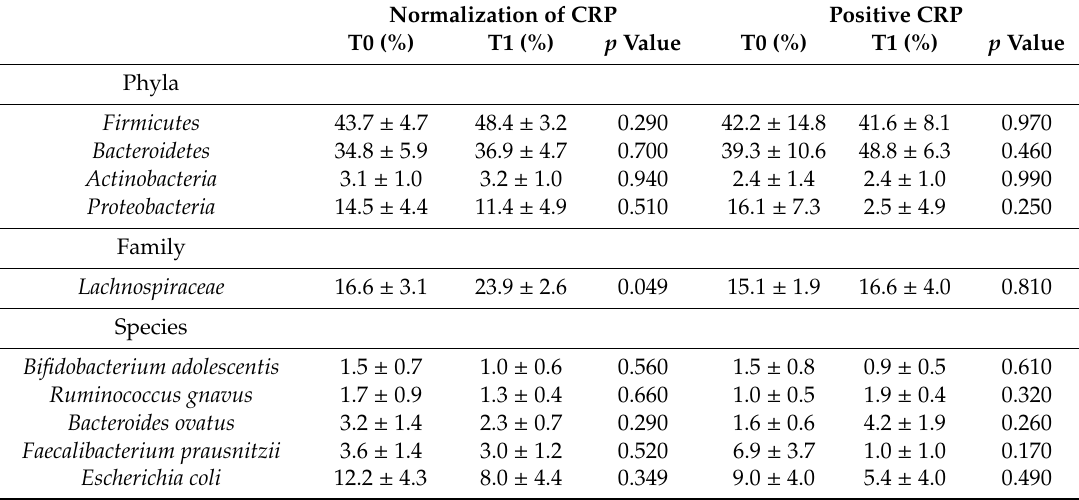
Table 5. Trend of the intestinal microbiome between T0 and T1 according to C-reactive protein levels at six